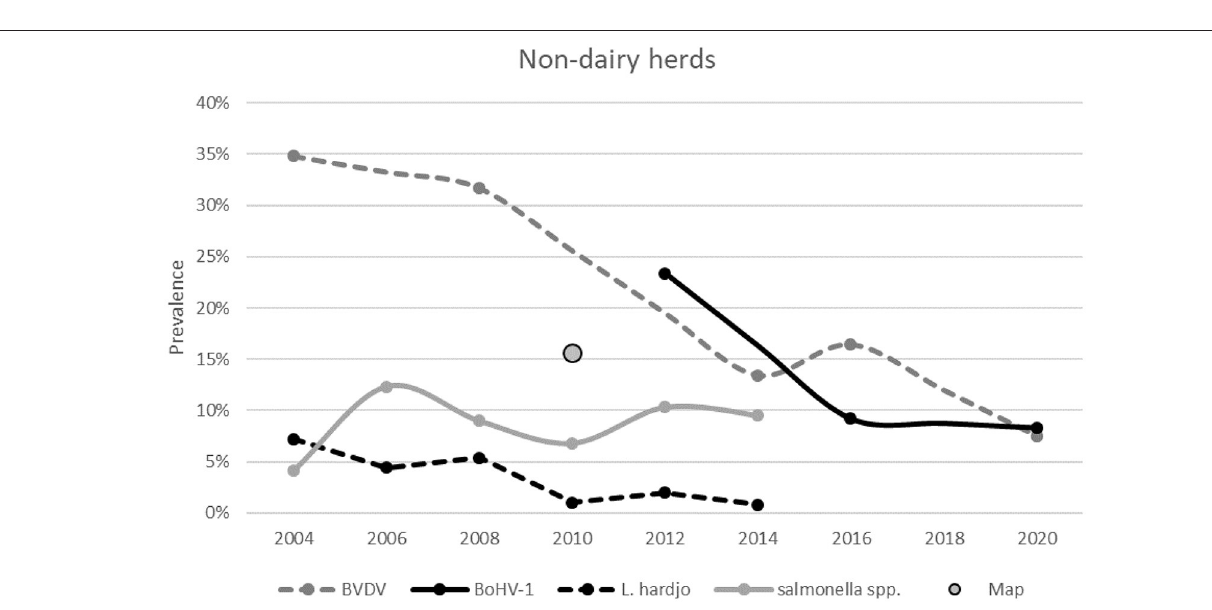
prevalence was observed for BVDV, BoHV-1 and L . Hardjo ( Figure 12 ) while the proportion of herds classified as free,